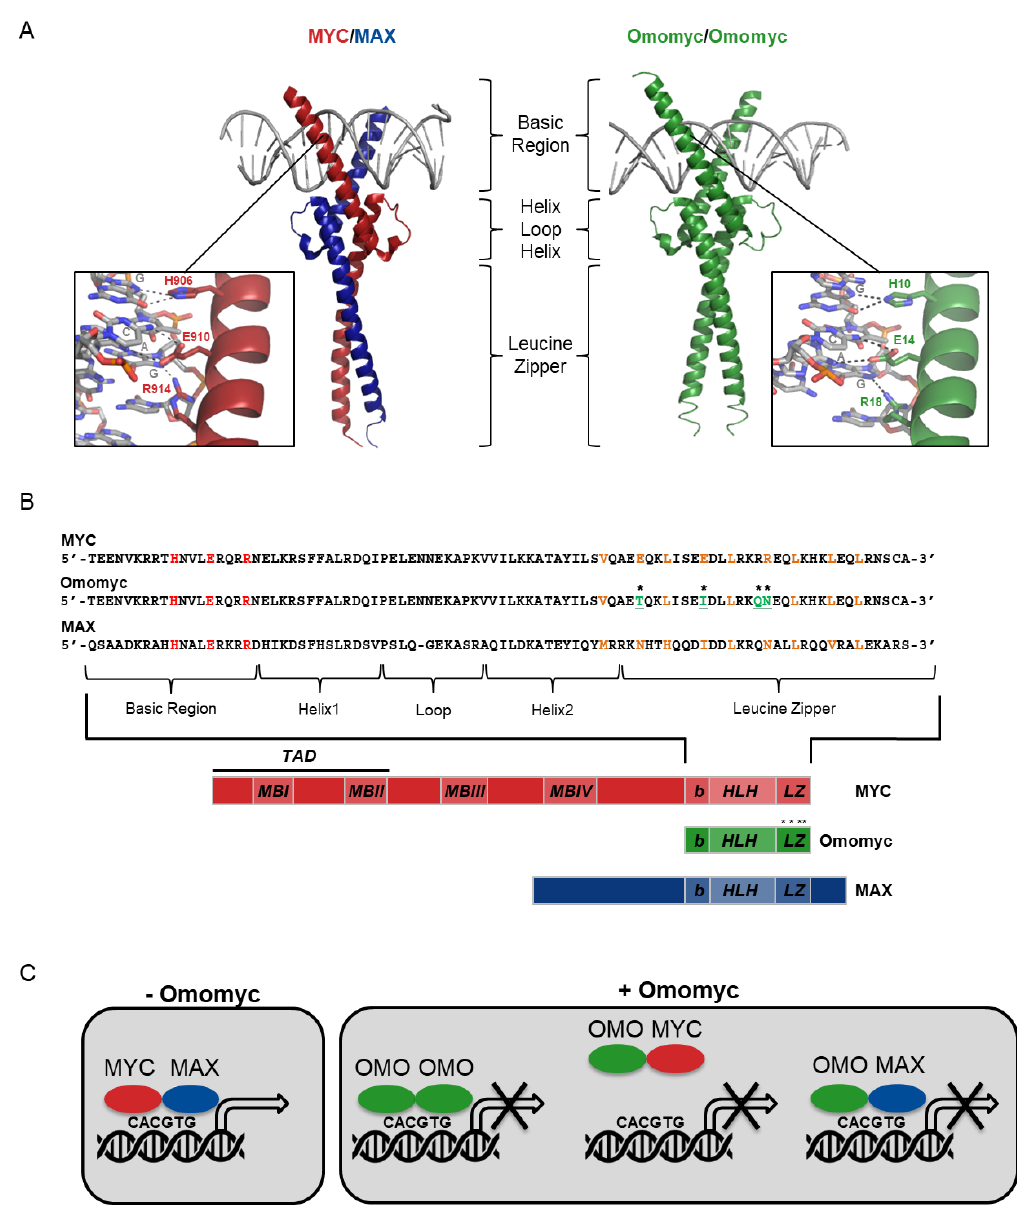
Figure 1. Omomyc acts as a dominant negative of Myc proteins. ( A ) Representation of the crystal structure of the MYC / Myc-associated protein X (MAX) dimer (1NKP, left) [12] and Omomyc /